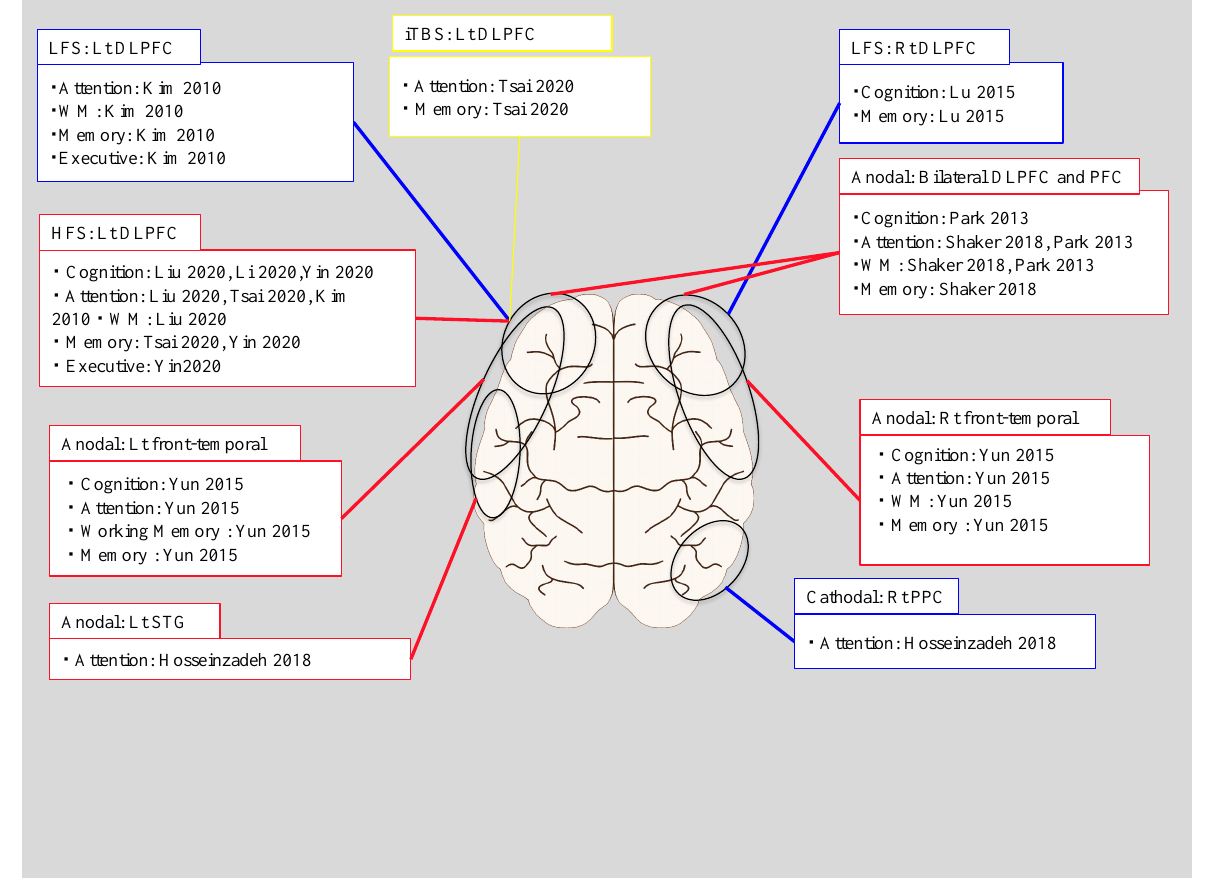
Figure 2. Relationship between stimulation site and neuropsychological test results in rTMS and tDCS. Abbreviations: DLPFC = Dorsolateral prefrontal cortex, PFC= Prefrontal cortex, PPC = Posterior parietal cortex, STG = superior temporal gyrus, LFS = Low frequency stimulation, HFS = High frequency stimulation, iTBS = intermittent theta-burst